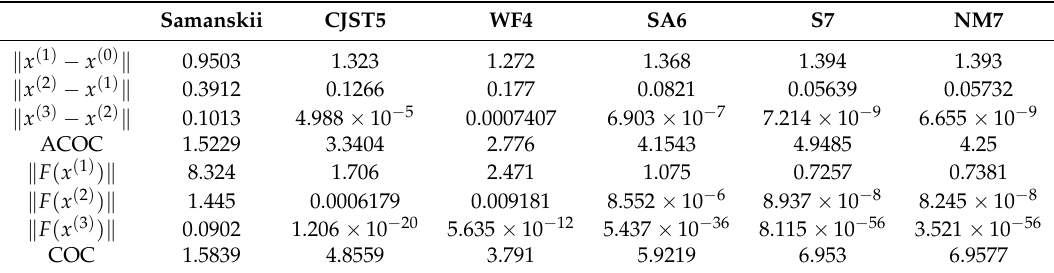
Table 7. Numerical results for Example